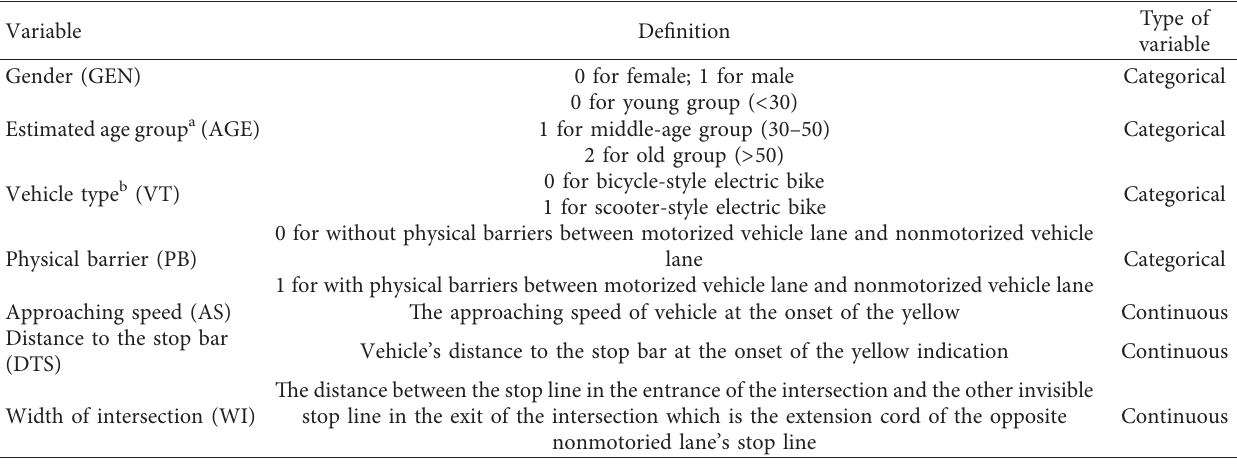
Table 2: Definition of variables